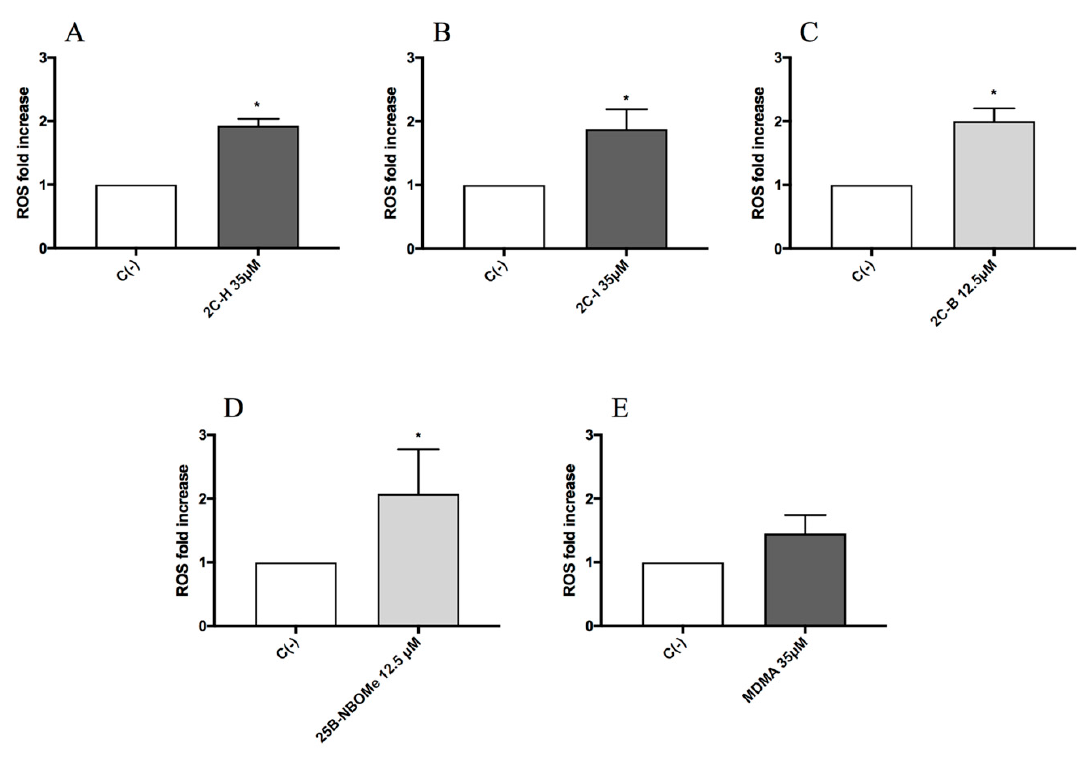
Figure 9. The ROS fold increase on TK6 cells after 1 h of treatment with 2C-H ( A ), 2C-I ( B ), 2C-B ( C ), 25B-NBOMe ( D ), and MDMA ( E ) at the indicated concentrations with respect to the untreated negative control C (-). Each bar represents the mean ± SEM of five independent experiments. Data were analysed using repeated ANOVA followed by t -test for paired data. * p < 0.05 vs. C (-).